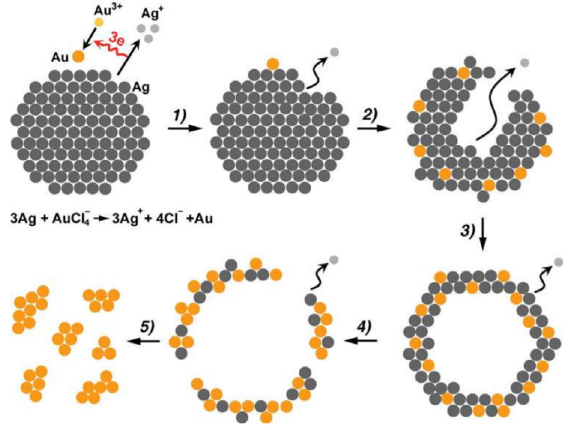
Figure 10 - Schematic illustration of the morphological and structural changes at different stages of the galvanic replacement reaction between a Ag nanoparticle and HAuCl in an aqueous solution. Adapted with permission from ref. (Xia et al. 2013) Copyright 2013